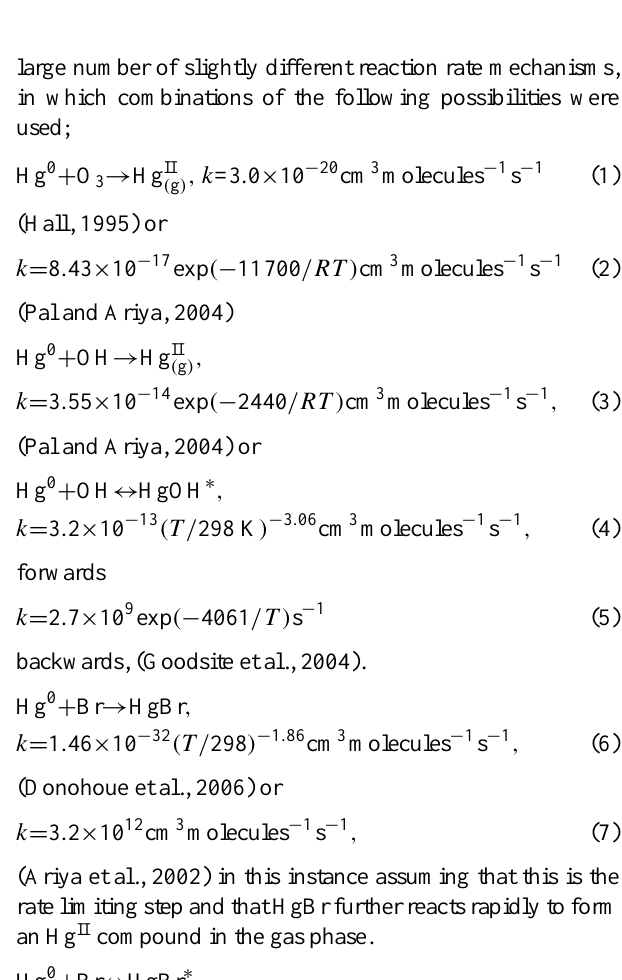
Fig. 5. The measured and modelled RGM concentration, assuming all reaction products contribute to RGM and using the Hg 0 + O 3 reaction rate constant from Hall (1995).